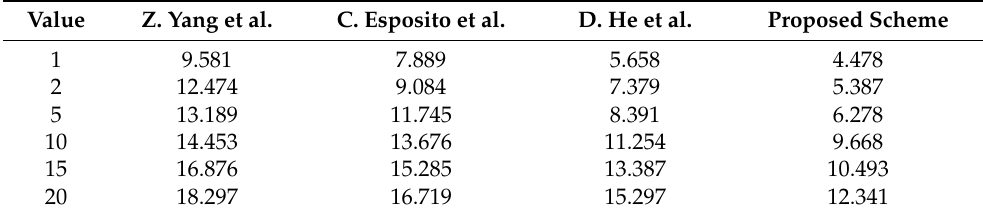
Table 6. Overhead of IoT integrity validation by number of subnet gateway servers. Units: %. Value Z. Yang et